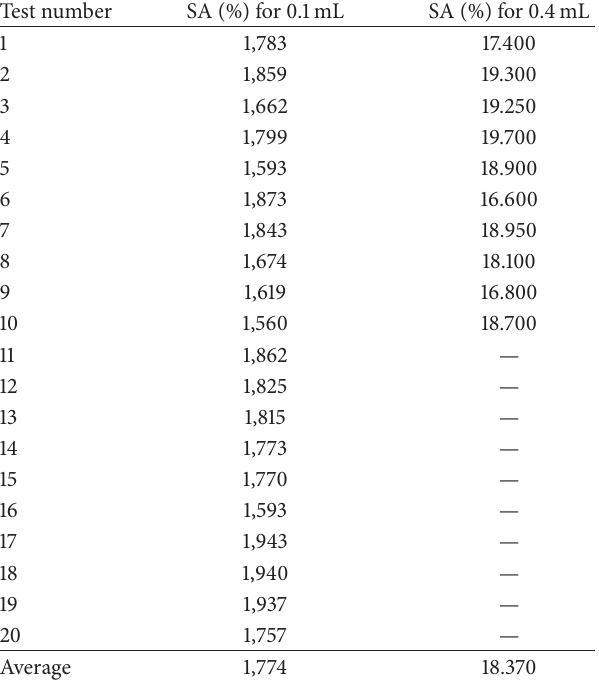
Table 3: Sensitivity average for the MST experiments to 0.1 and 0.4 mL